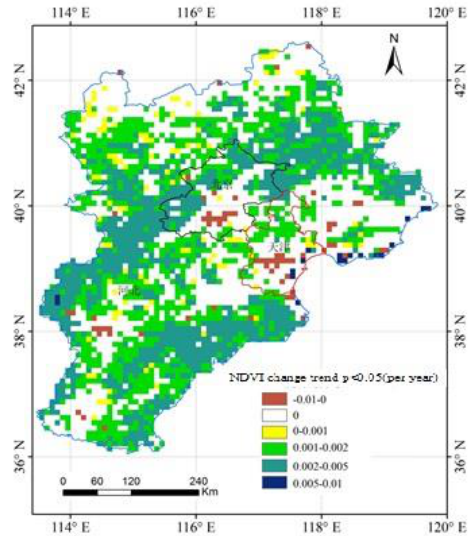
Figure 3 Significant variation trend distribution of GIMMS NDVI in the Beijing-Tianjin-Hebei region between 1982 and 2013